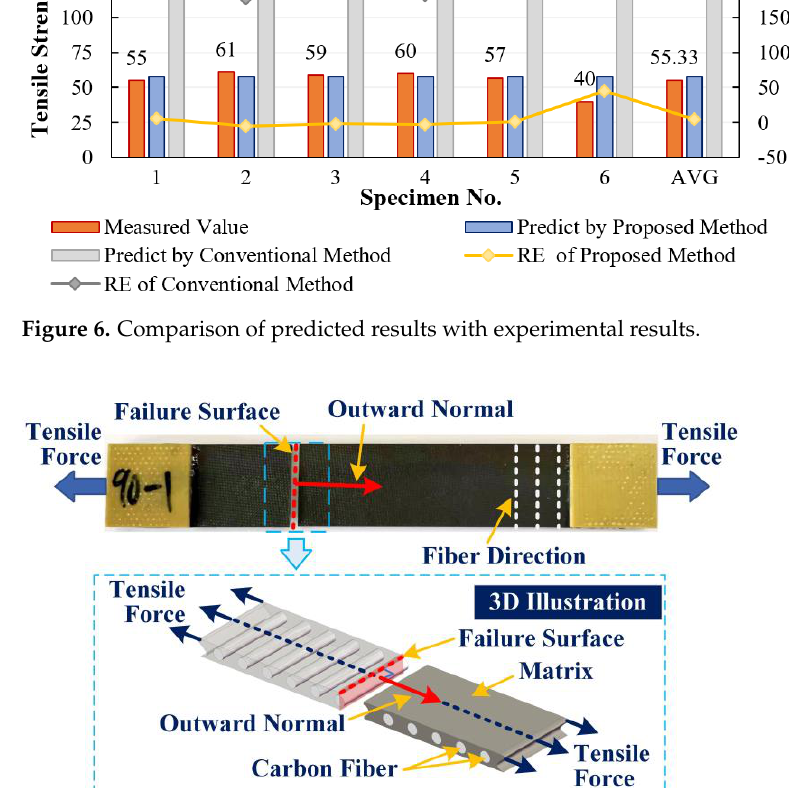
Figure 7. Fractured specimen illustration.